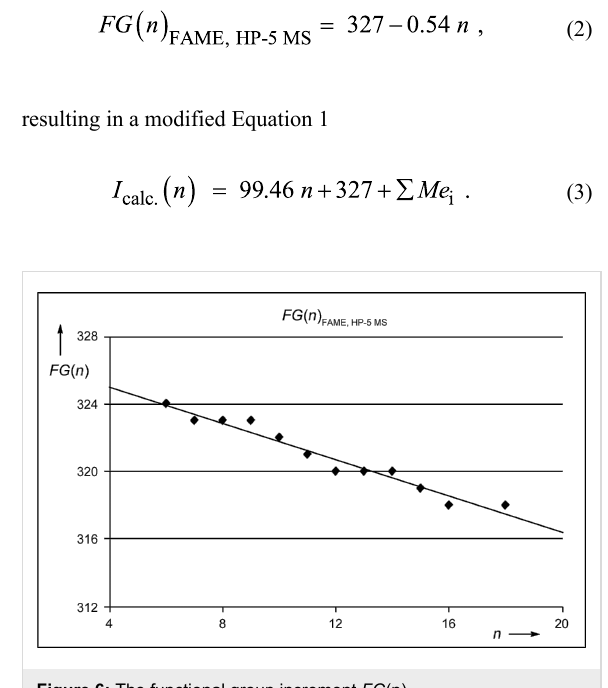
Figure 6: The functional group increment FG (n) FAME, HP-5 MS .